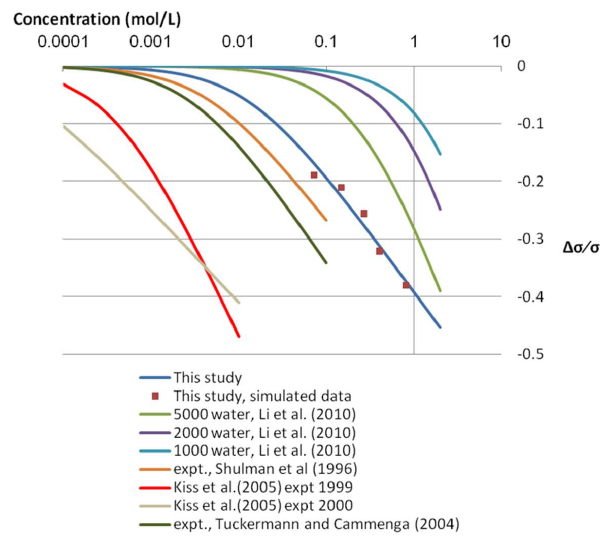
Fig. 5. Fitted Szyszkowski curves from five different